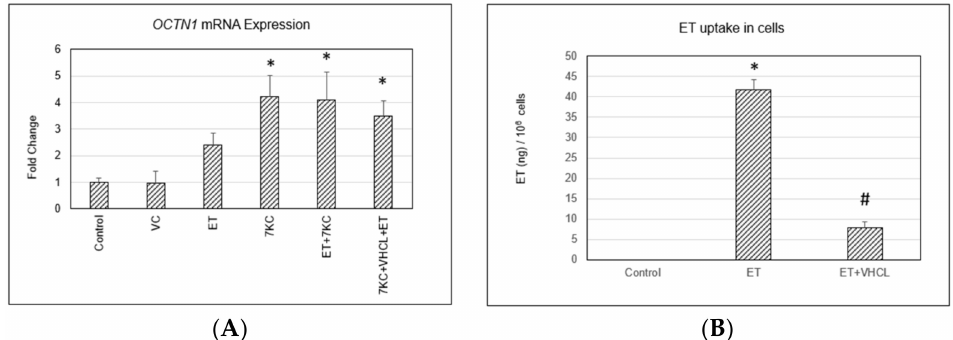
Figure 2. Quantitative RT-PCR of the OCTN1 gene and ET uptake in cells. ( A ) Treatment of cells with VHCL did not alter the expression of OCTN1 , and treatment with ET induced a non-significant, 2-fold increase in transporter expression. In contrast, 7KC induced a significant, 4-fold increase in OCTN1 mRNA expression. This increase was not affected by the addition of ET or VHCL. ( B ) Treatment of cells with ET significantly increased ET levels in cells, but levels were significantly reduced by cotreatment with VHCL. VC: Vehicle control; ET: 1 mM ET; VHCL: 100 µ M VHCL; 7KC: 30 µ M 7KC. Data are represented as the mean ± SD (n = 3). * Significant difference compared to controls ( p < 0.05). # Significant difference compared to ET. Data were analysed by one-way ANOVA with Bonferroni’s multiple comparison post-hoc